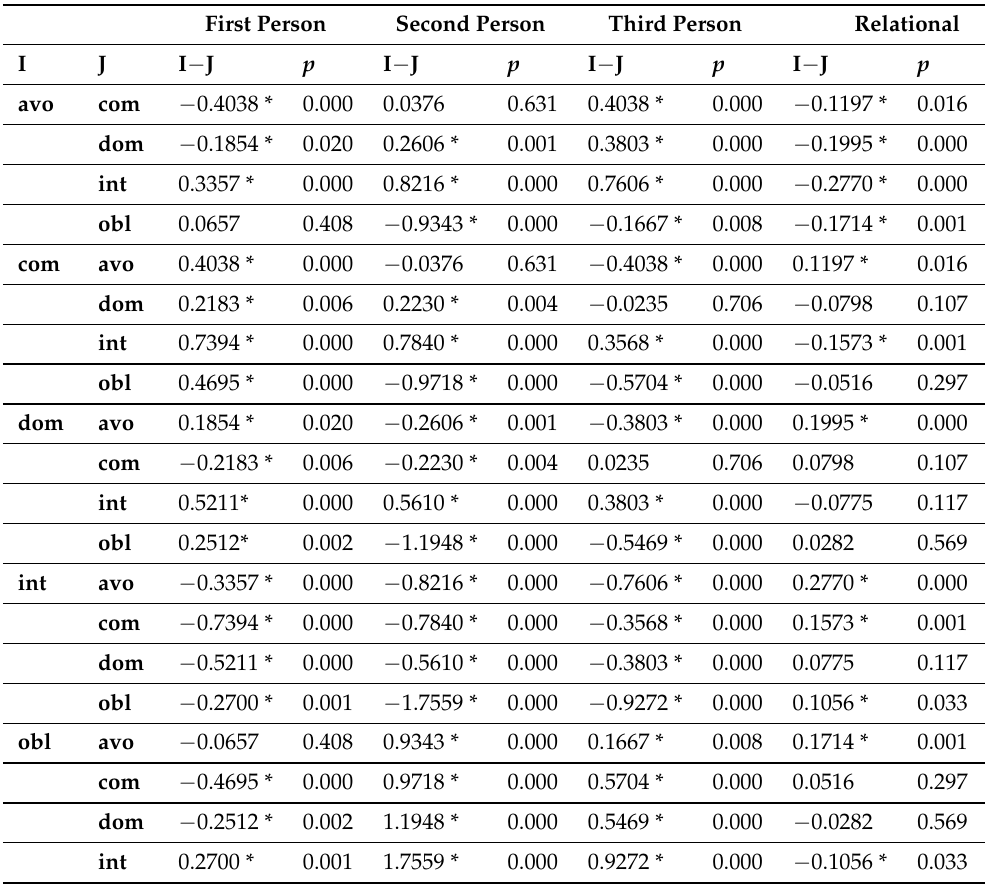
Table 4. Post-hoc significance level between the number of pronouns and the ROCI-II prevalent style. Estimated mean differences and p -values are reported. (*) Significant differences ( p < 0.05) are marked with